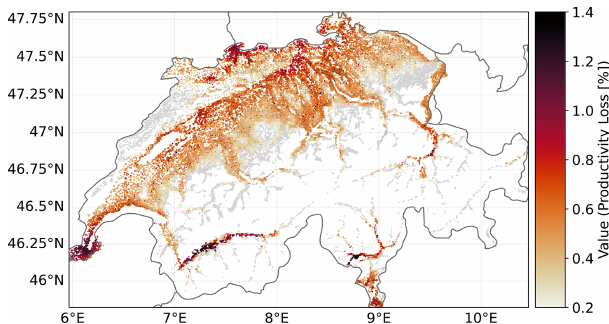
Figure 6. Map showing the spatial impact for labour productivity in percentage compared to the total exposure value for the year 2050, the RCP8.5 scenario, and the category high physical activity.